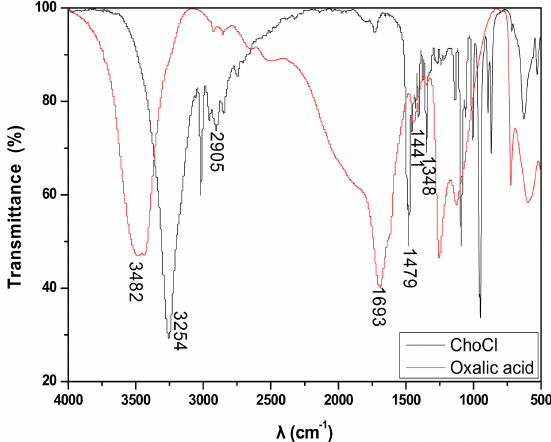
Figure 5. The IR spectrum of choline chloride and oxalic acid.